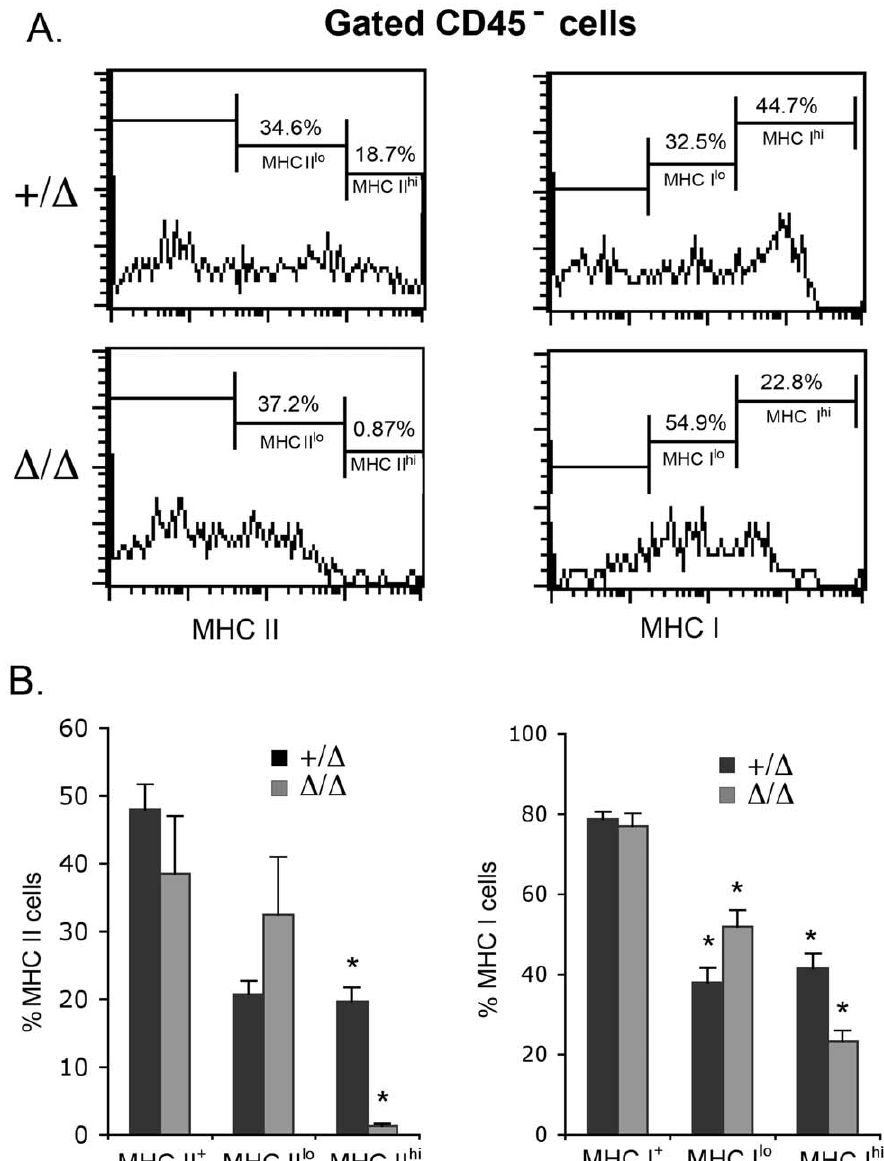
Figure 5. Changes in MHCII and MHC I expression on Foxn1 D / D TECs. A, histograms showing representative profile of MHC II (left) and MHC I (right) expression on gated CD45 2 thymic stromal cells from Foxn1 + / D and Foxn1 D / D mutant C57BL/6J mice. B, the percentage of MHC II + and MHC II hi cells (left), MHC I + and MHC I hi cells (right) in gated CD45 2 thymic stromal cells from Foxn1 + / D and Foxn1 D / D mutant C57BL/6J mice. (*, p , 0.05).